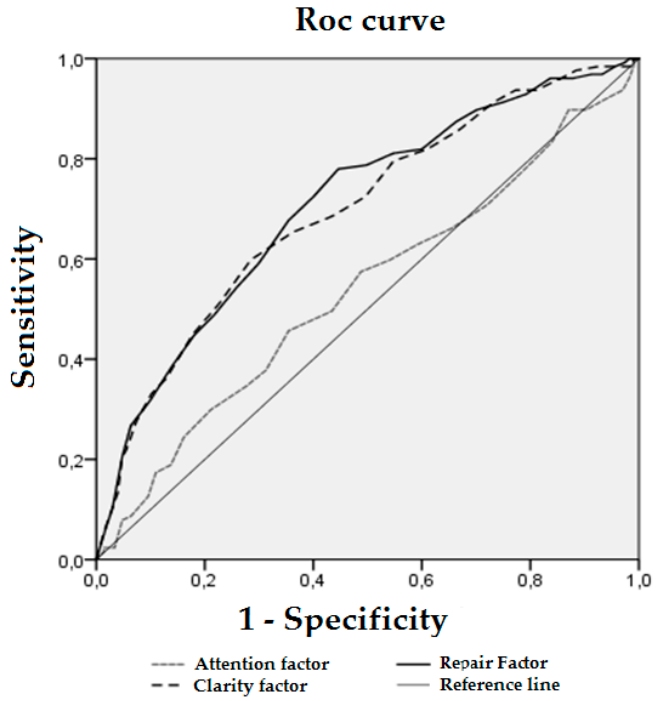
Figure 1. ROC curve for the TMMS-24 dimensions predicting the presence of high happiness.